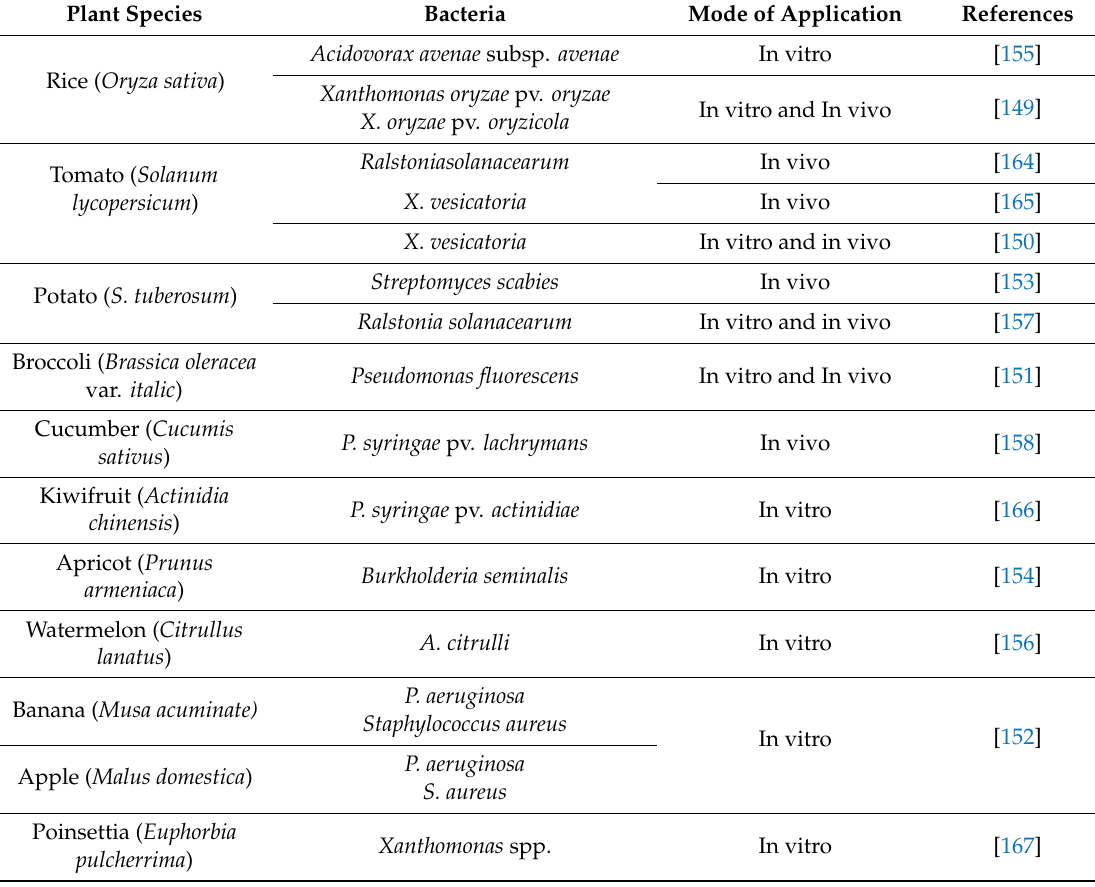
Table 3. Antibacterial e ff ects of CHT on bacterial plant